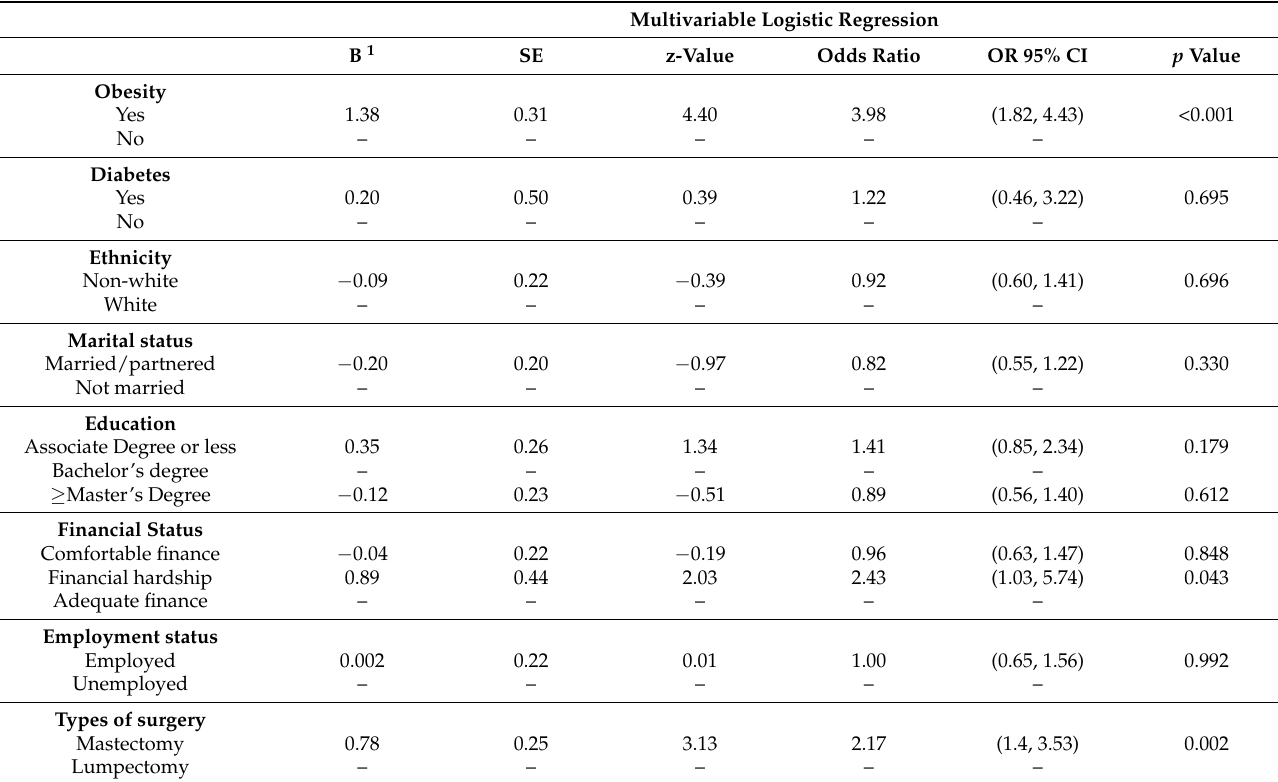
Table 5. Multivariable logistic regression for arm swelling ( N =